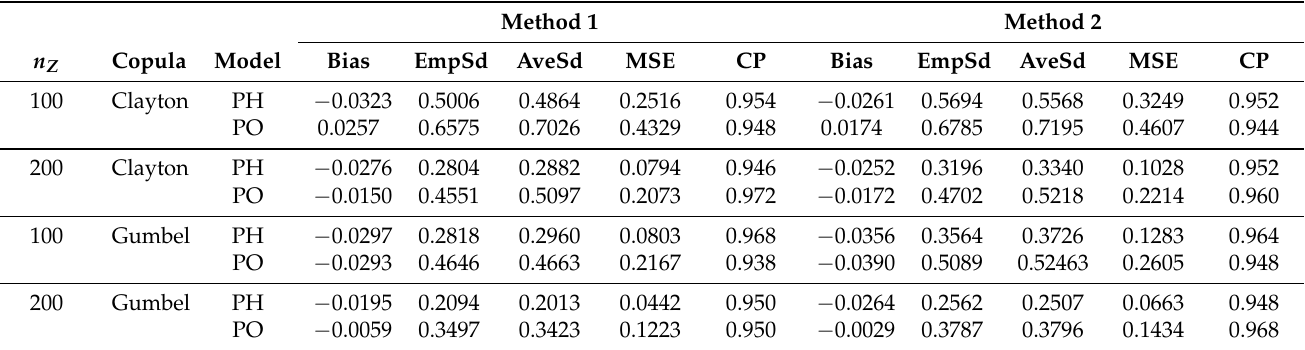
Table 1. The estimators of θ under Case 1 with τ = − 0.05 when the variable of interest is Y.